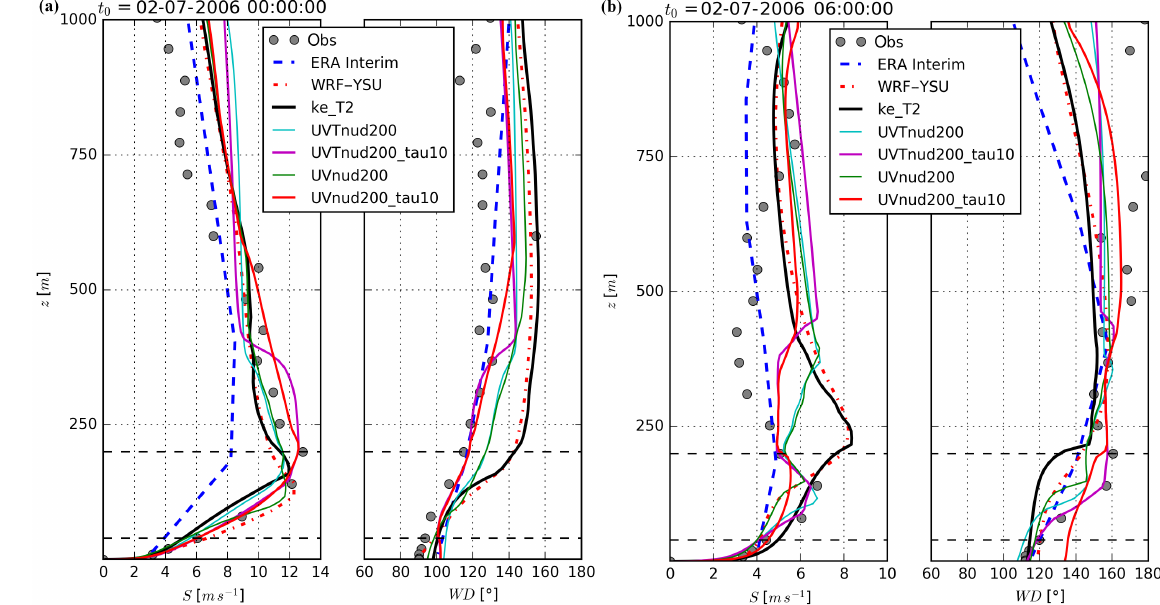
Figure 13. Vertical profiles of horizontal wind speed S and wind direction WD at 2 July 2006 00:00:00 (a) and 06:00:00 (b) using different nudging strategies as per Table 1 and compared with the reference SCM (without nudging, ke_T2), the WRF simulation, the ERA Interim input data and the